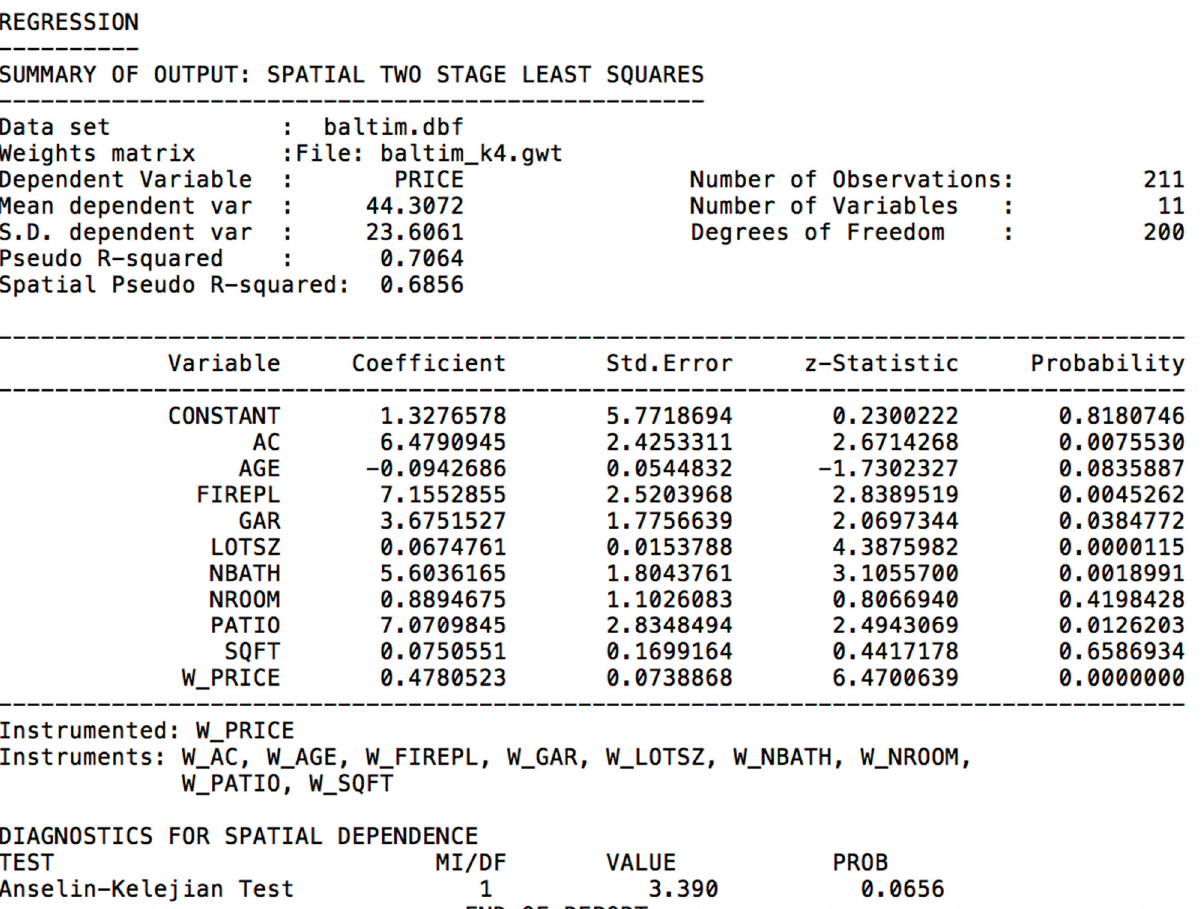
Figure 2. GeoDaSpace for spatial econometrics functionality from